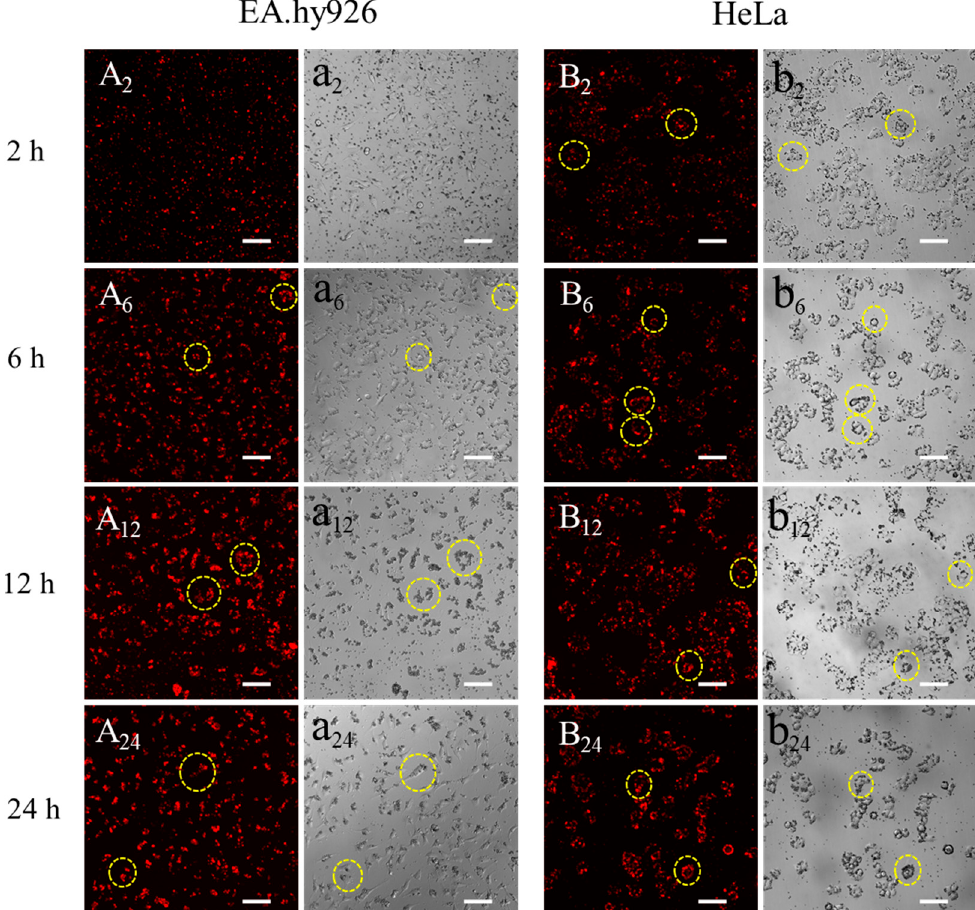
Figure 8. Fluorescent images of QD-SFMPs cultured with ( A , a ) EA.hy926 cells and ( B , b ) HeLa cells. A and B denote the fluorescent field, while a and b denote the bright field, and 2, 6, 12, and 24 denote incubation time was 2 h, 6 h, 12 h, and 24 h, respectively. Scale bar: 100 μ m. The yellow circles indicated that the QD-SFMPs likely tended to adhere to the cell surface.